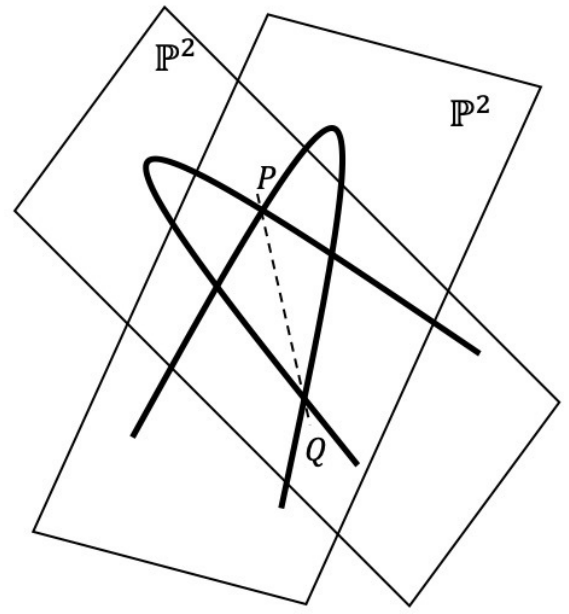
Figure 1 . Union of two conics intersecting in two points, P; Q . Each of the two conics lies inside a hyperplane that is isomorphic to P 2